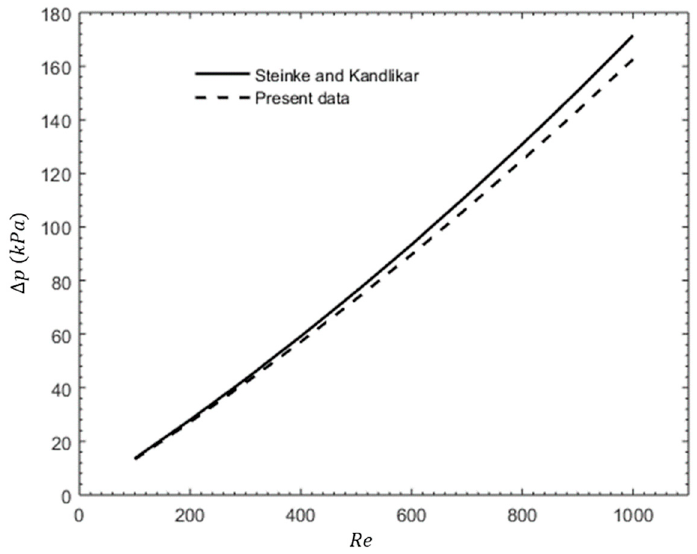
Figure 3. Relationship between ∆ p and Re for validation of numerical simulation and Steinke Kandlikar formulation results.